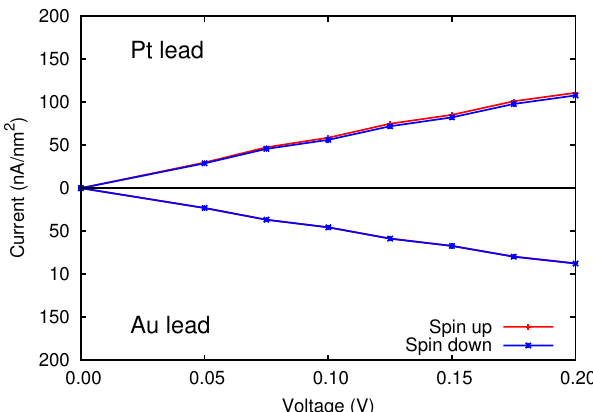
Figure 4. Spin resolved current of the symmetric devices, as a function of the applied bias